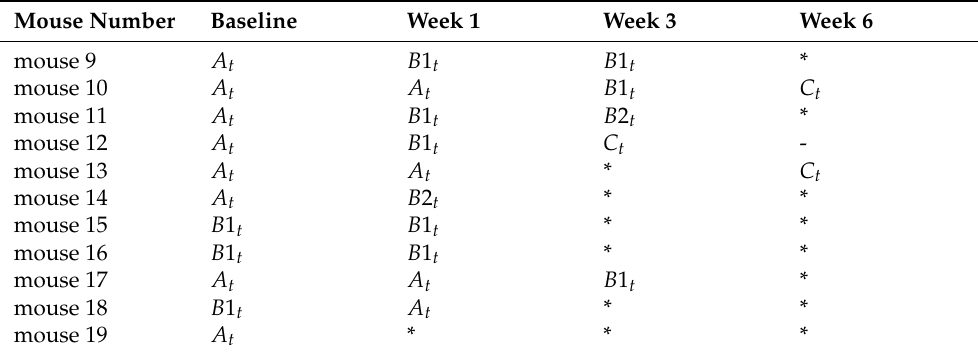
Table 6. Clusterization of the 11 sunitinib mice from the validation group. Items marked as - indicate that the RF approach was unable to assign the record to one any of the A t , B 1 t , B 2 t , C t clusters. Items marked as * indicate no PETRUS data